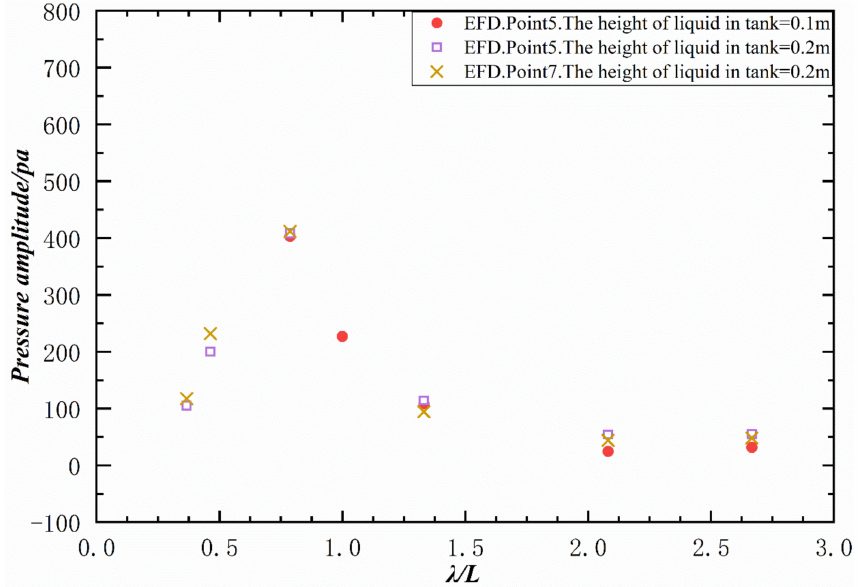
Figure 16. The pressure amplitude of two points on the